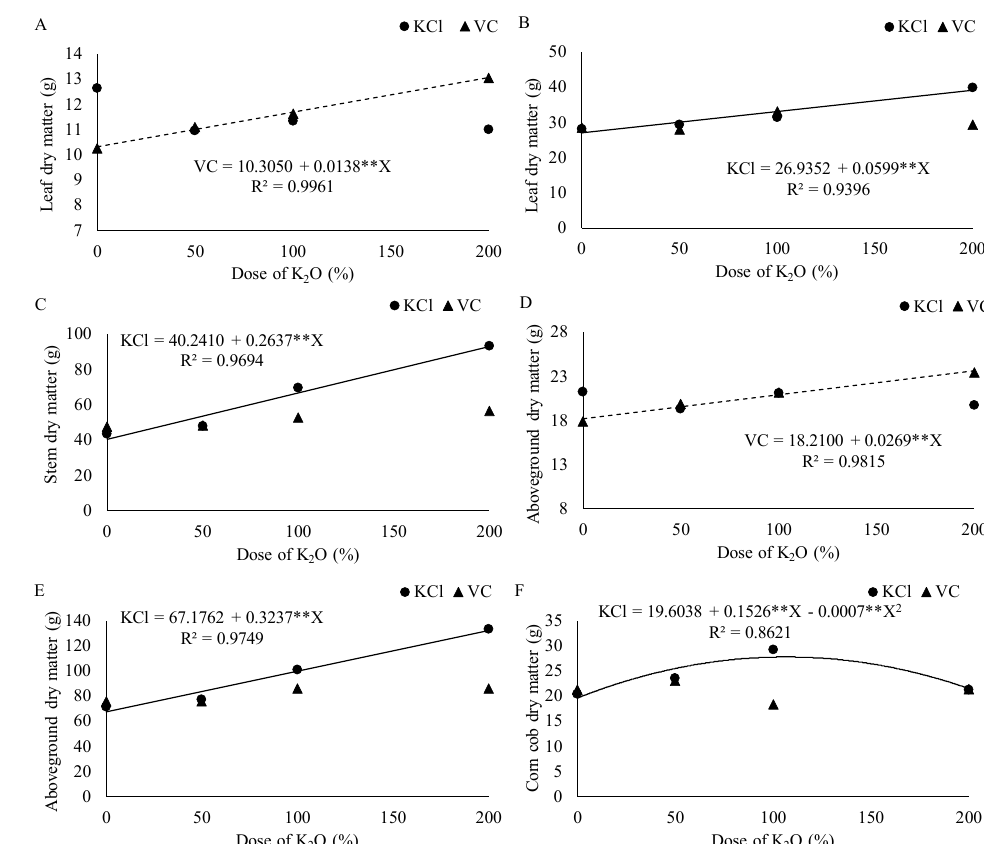
plant) was recorded at the 109% dose (Figure 2F).